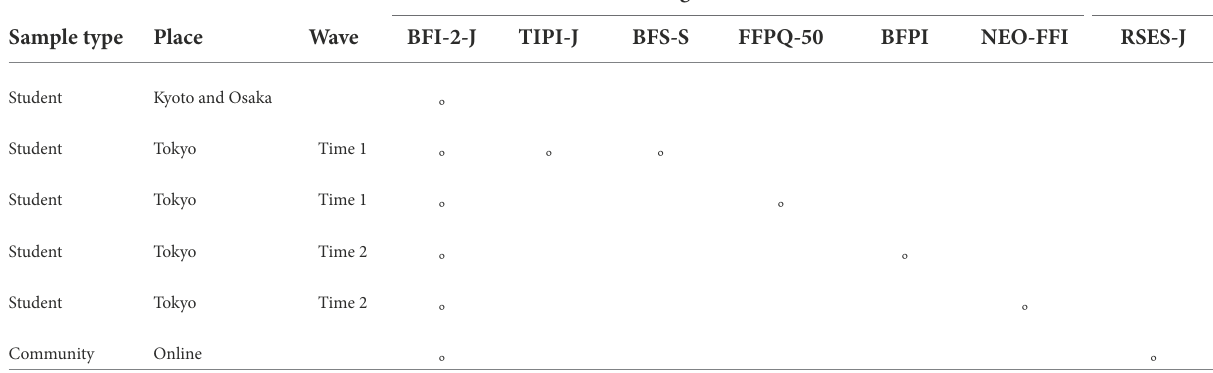
TABLE 1 Survey and assessing